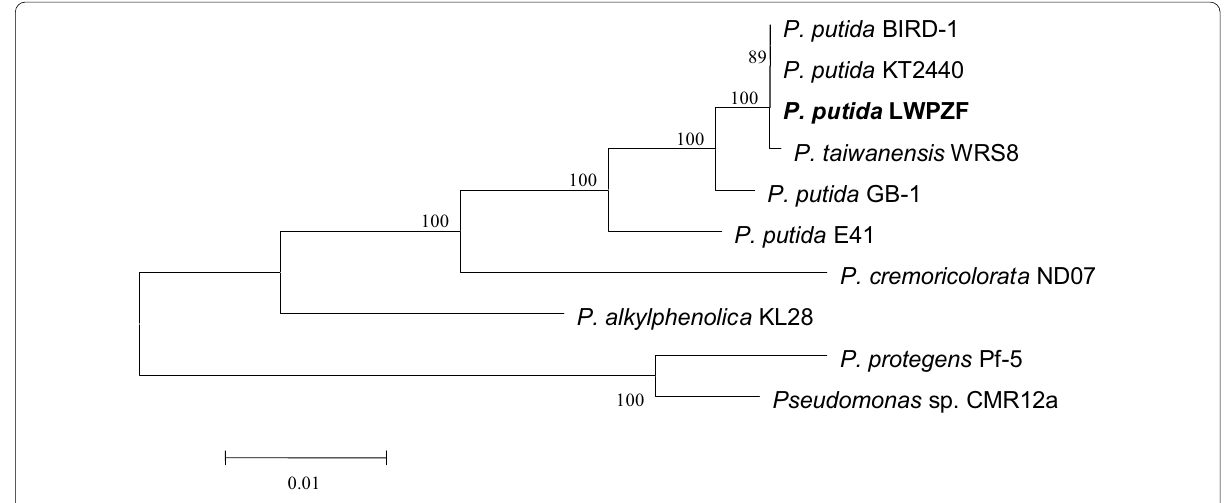
Fig. 4 Phylogenetic relationship of marker proteins of strain LWPZF and related Pseudomonas species